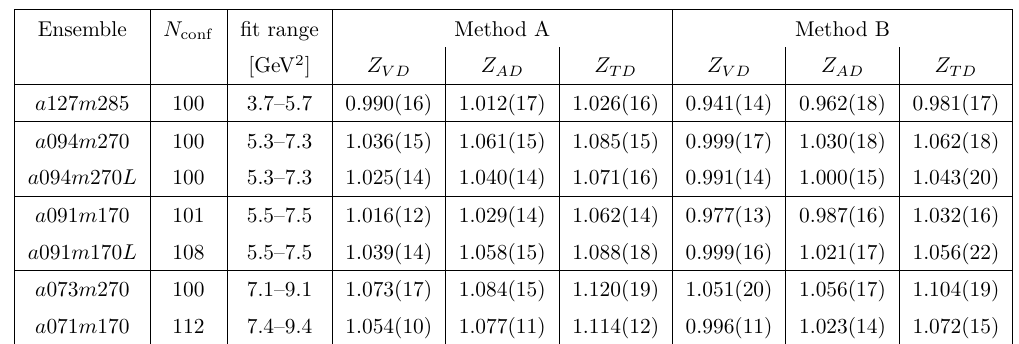
Table 10 . Results for the renormalization factors, Z V D,AD,TD , in the MS scheme at 2 GeV. These are calculated in the RI’-MOM scheme as a function of scale p = √ p on the lattice, matched µ p µ to the MS scheme at the same scale µ = p , and then run in the continuum MS scheme from µ to 2 GeV. Results are given for two methods used to remove the p 2 dependent artifacts as described in the text. In method A (columns 4–6), the Z ’s are obtained by averaging the data shown in figure 11 over the range of p 2 specified in the in the third column. Results using method B (columns 7–9) are obtained using fits to the data starting at the lower value of p 2 given in column 3 with the ansatz Z ( p ) = Z 0 + ap 2 + bp 4 .